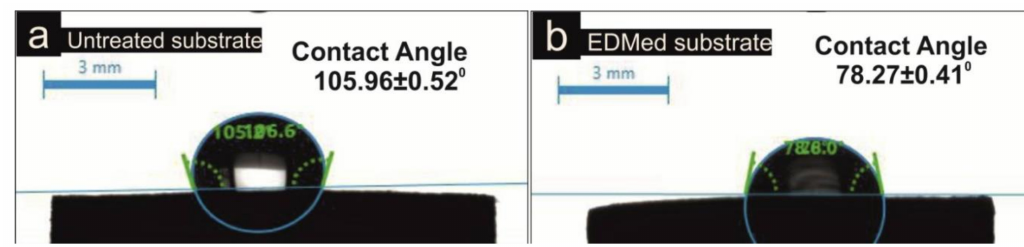
Figure 8. Contact angle illustration of ( a ) Untreated surface; ( b ) EDMed